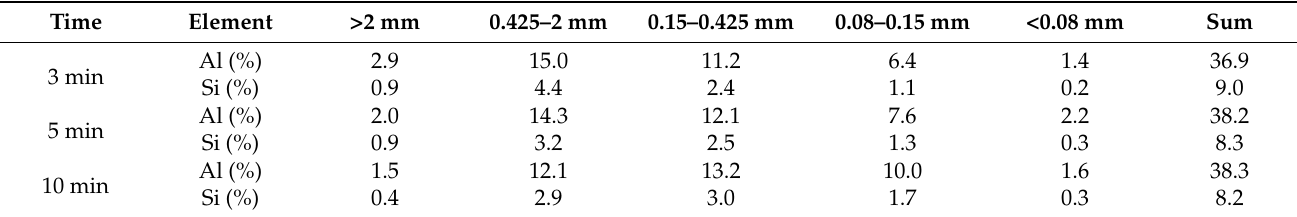
Table 1. Mass fractions of elements obtained with steel bar